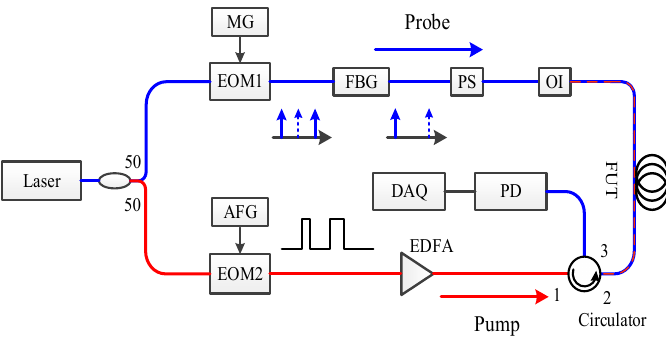
Figure 1. Experiment setup of the differential pulse pair Brillouin optical time-domain analysis (DPP-BOTDA). EOM, electro-optic modulator; MG, microwave generator; FBG, fiber Bragg grating; PS, polarization scrambler; OI, optical isolator; AFG, arbitrary function generator; EDFA, erbium-doped fiber amplifier; PD, photodetector; DAQ, data acquisition.